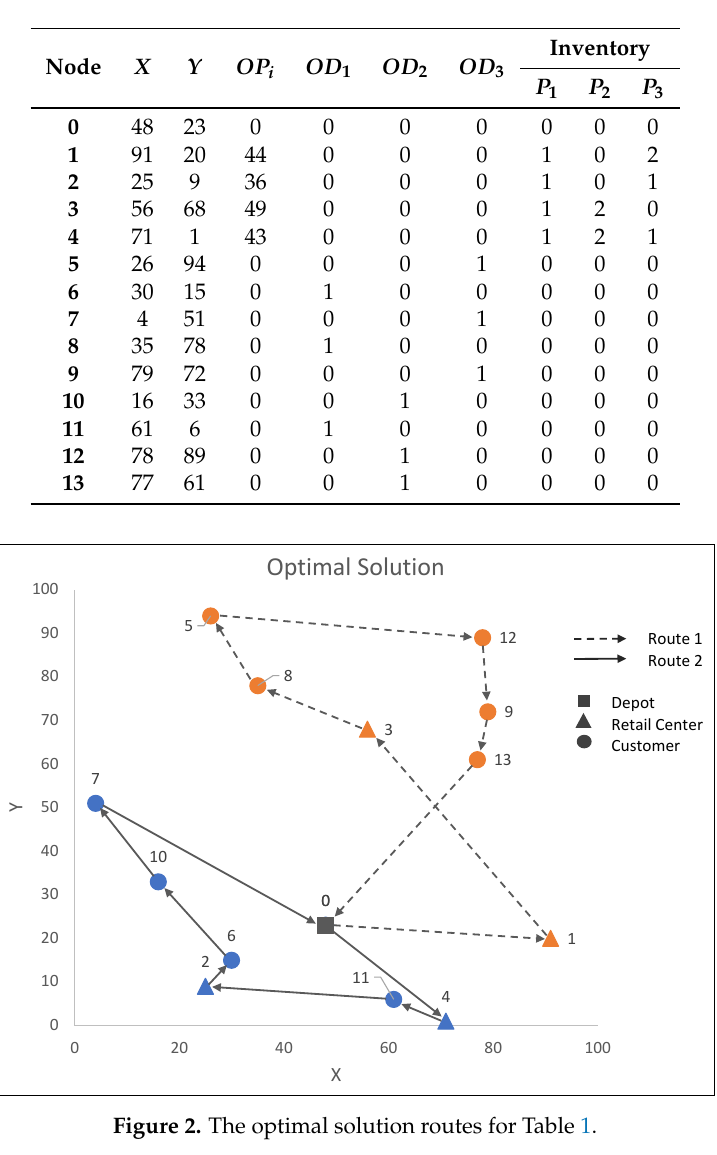
Table 1. Problem instance data.